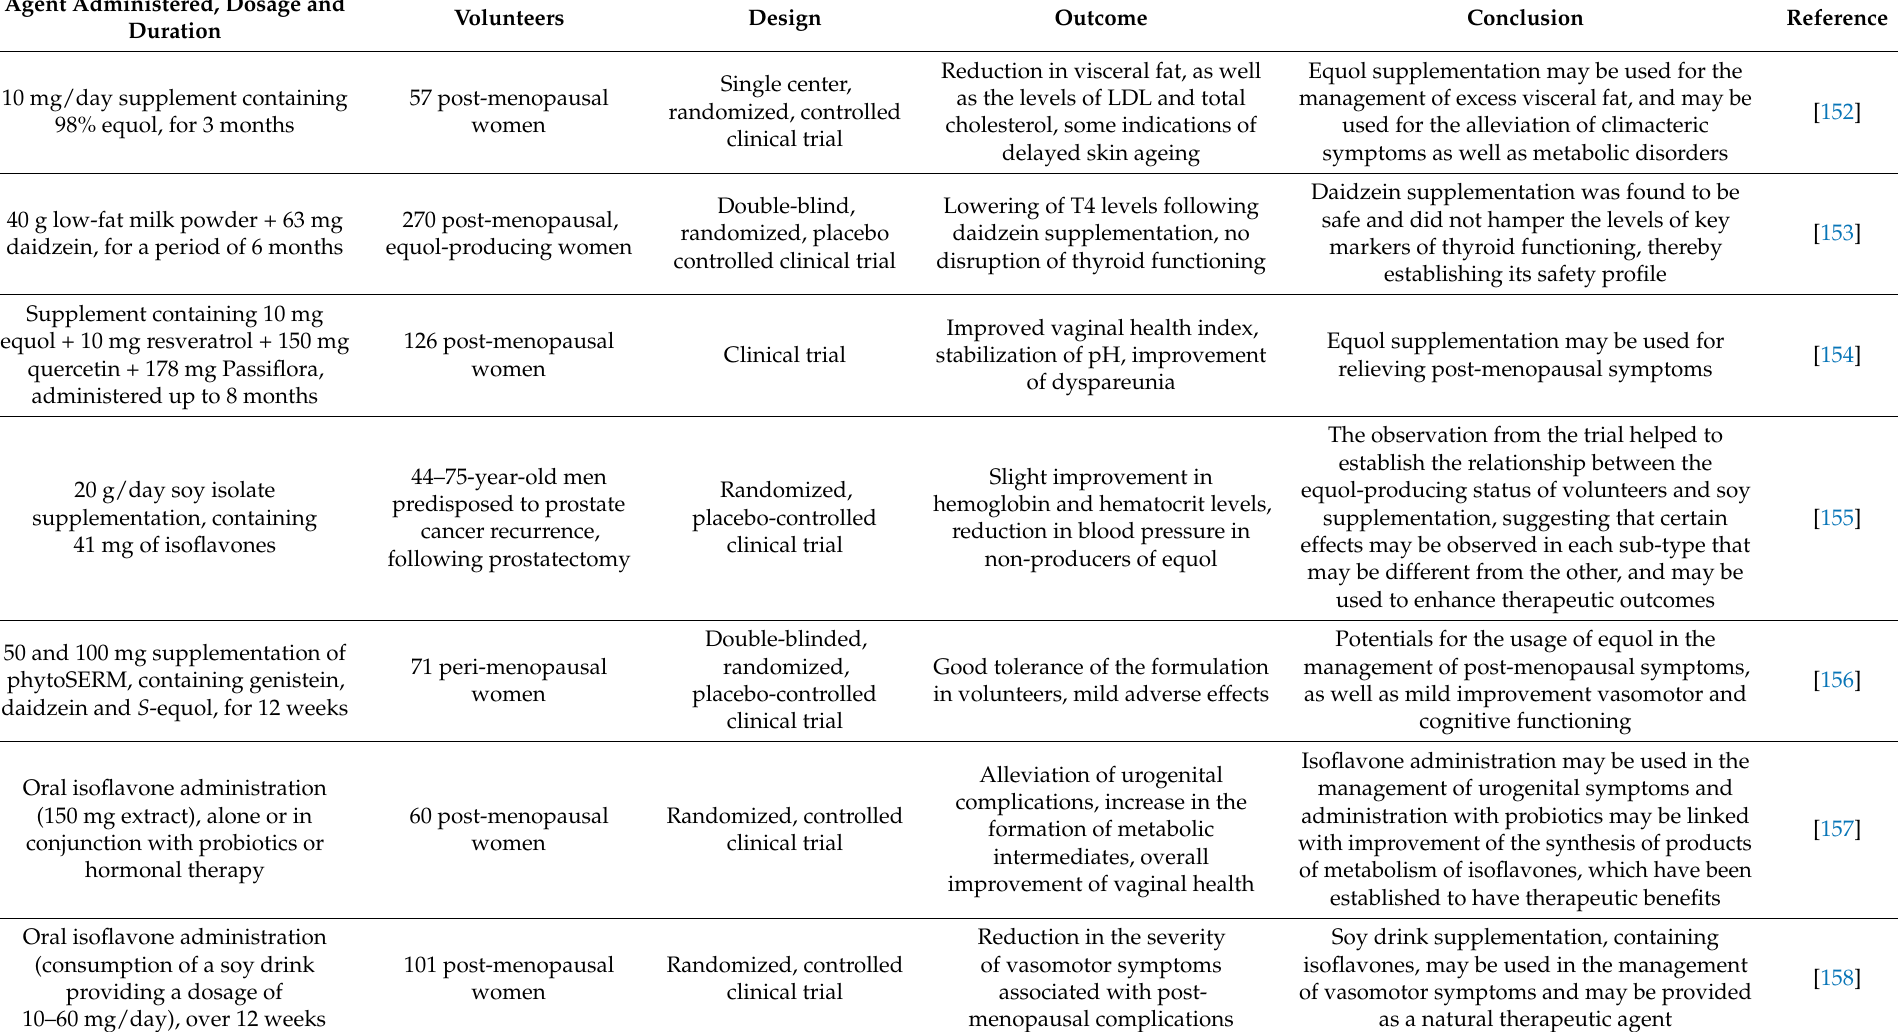
Table 3. Clinical applicability of equol in the management of human